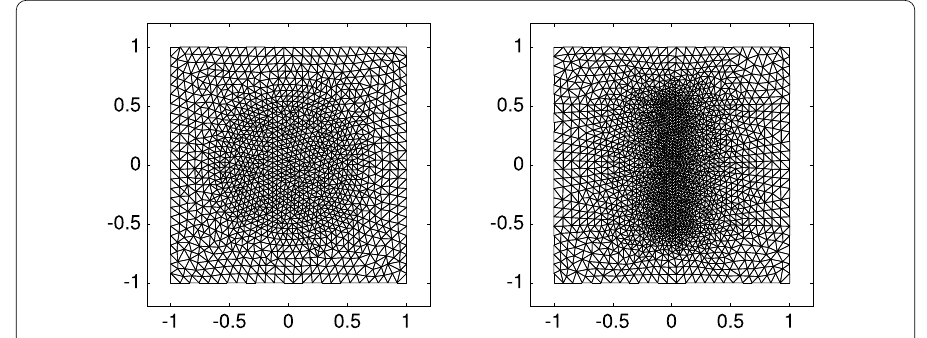
Figure 5 Square computational domain ¯ (cid:4) = [–1,1] 2 and the triangular mesh used in the computations: one circle (left); three circles